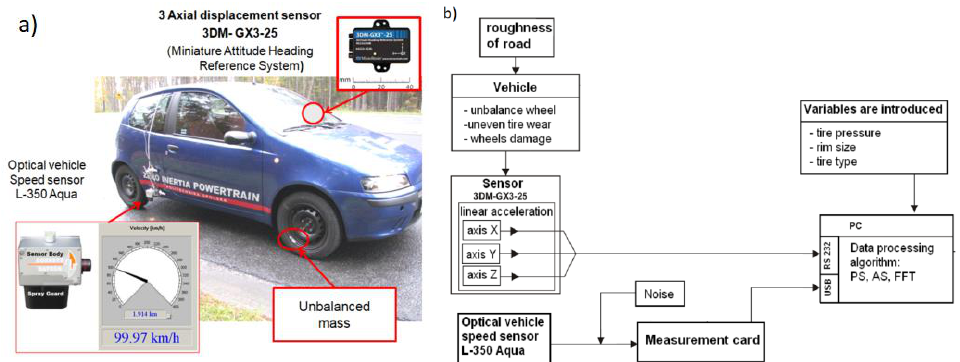
Figure 2. Test vehicle ( a ) and block diagram of the measurement system ( b ).